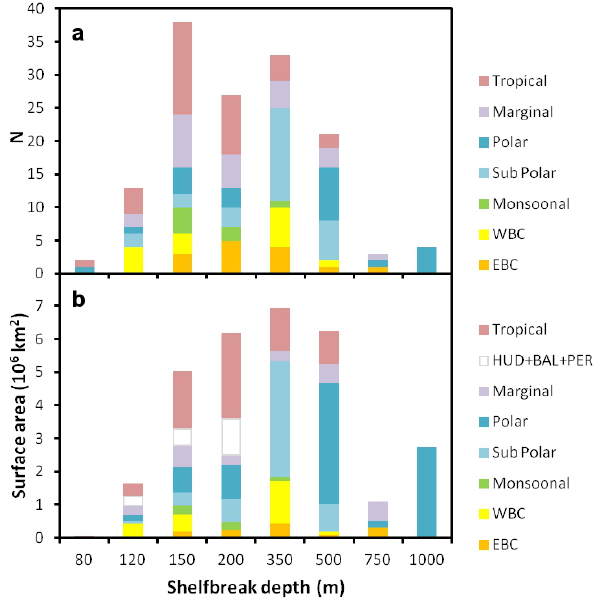
Fig. 3. Repartition of the depth at which the shelf breaks for each COSCAT segment (top, a – number ( N ) of COSCAT segments per shelfbreak depth) and integrated surface area of continental shelves (bottom). The colour code represents the type of